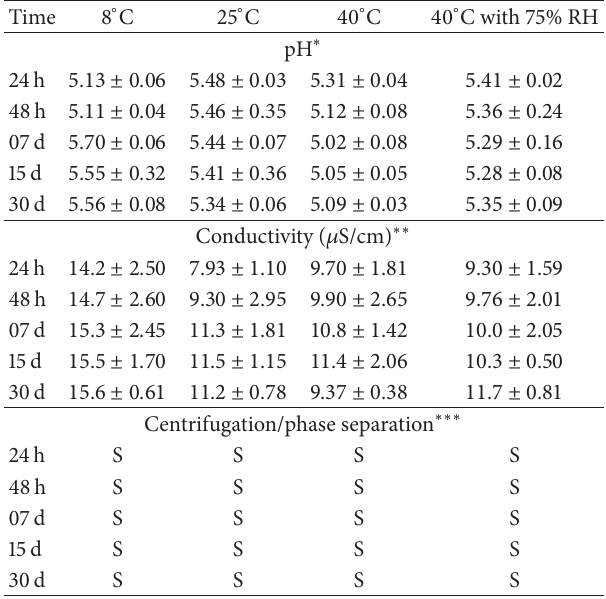
Table 3: Centrifugation, mean conductivity, and pH values of 5% green tea multiple emulsions kept at different storage